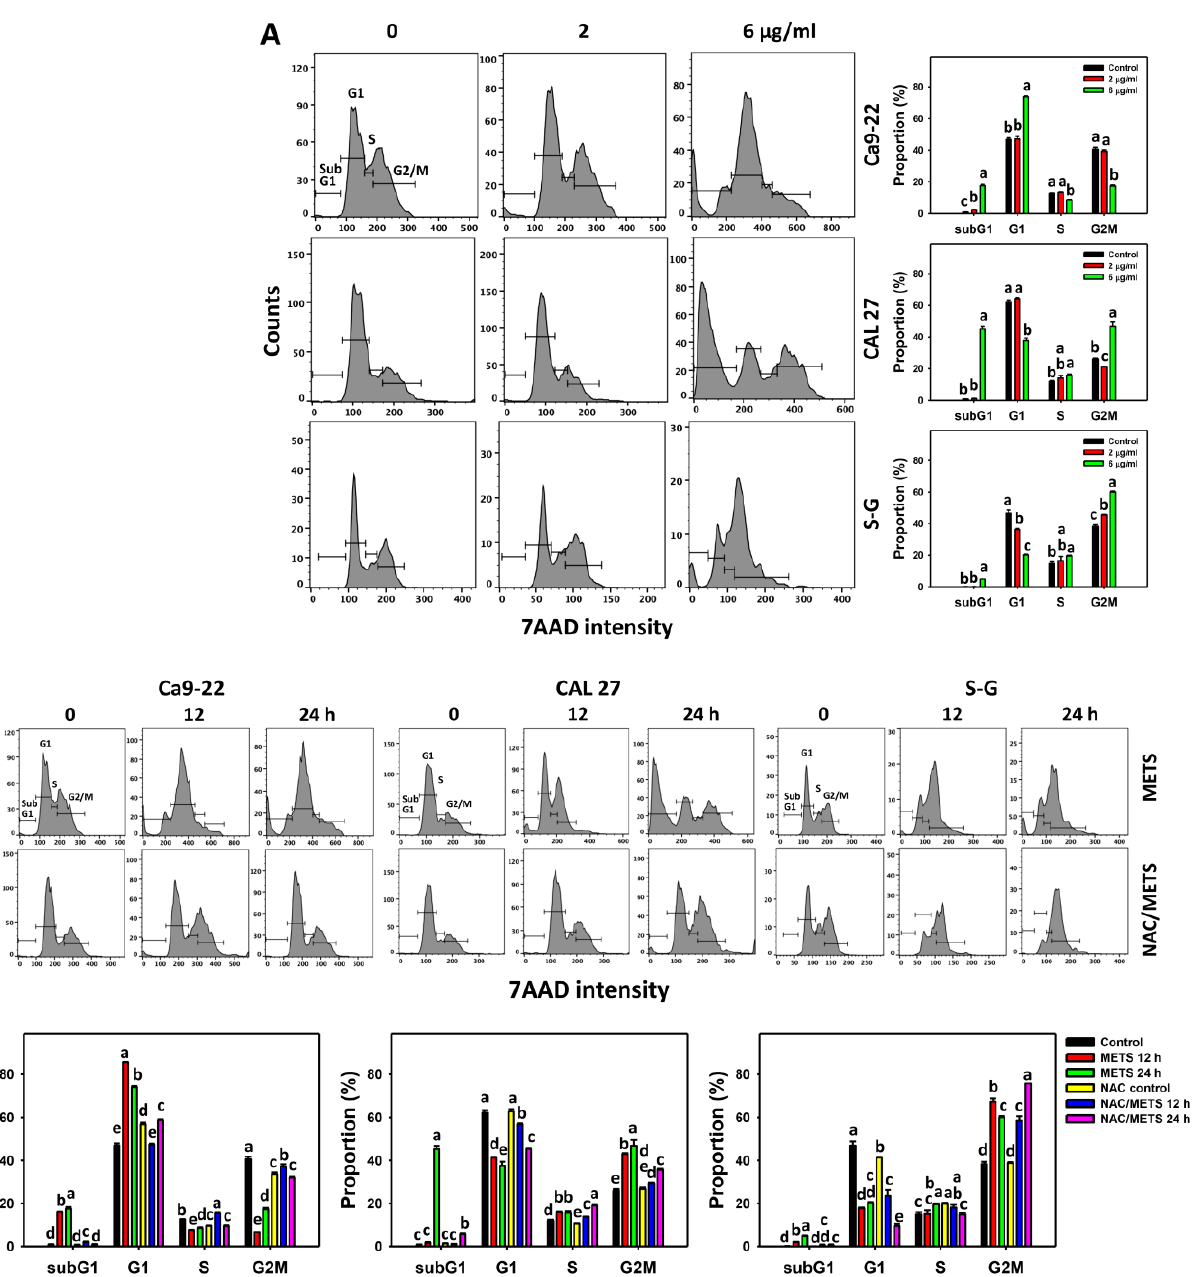
Figure 3. METS causes subG1 accumulation of oral cancer cells. ( A ) Cell cycle changes. Cells were treated with METS for 24 h. Oral cancer and normal cells (S-G) were included. ( B ) NAC response on cell cycle of METS treatment. Untreated control and NAC pretreatment were followed by posttreatment of vehicle control and METS (6 µ g/mL) for 0, 12, and 24 h, i.e., control, NAC, METS, and NAC/METS, respectively. Data = mean ± SD ( n = 3). Data showing non-overlapping lower-case letters have significant results ( p < 0.05) as analyzed by the one-way ANOVA analysis and post hoc test.